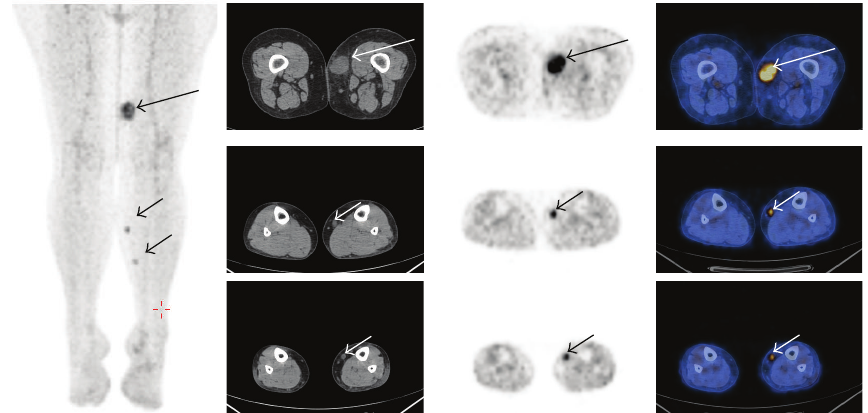
Figure 3: False negative a 35-year-old patient with a large round cell liposarcoma of the right ankle (top, small arrow) required nephrectomy for a large infrarenal mass (bottom, long arrow) which in retrospect was a non-FDG-avid lesion on the staging FDG-PET scan (middle, long arrow).